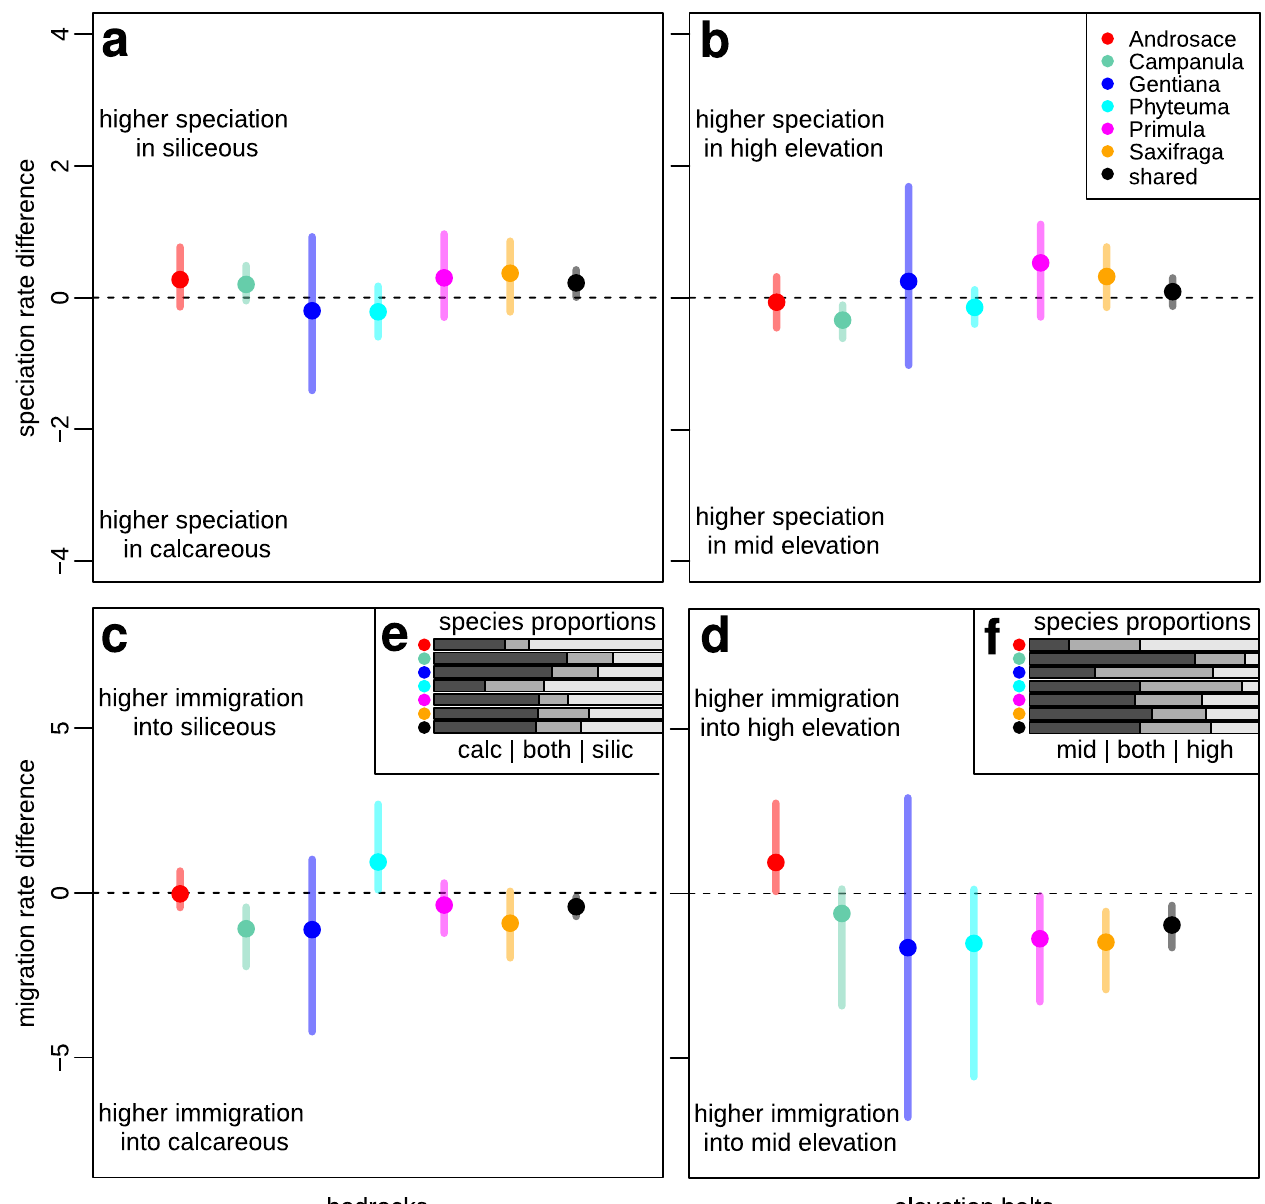
Fig. 3 Evolutionary assembly across bedrocks and elevational belts based on ClaSSE models. a , c The differences between siliceous and calcareous habitats in constant-state speciation and migration rates, respectively. b , d The differences between high and mid-elevation habitats in constant-state speciation and migration rates, respectively. The dots represent mean parameter estimates and the bars indicate 95% credibility intervals, based on 5000 MCMC samples from the ClaSSE model posterior. Black dots and bars represent the shared parameter estimates from the multi-clade model, where each of the 6 phylogenies is regarded as an independent realization of the same diversi fi cation process. e The proportions of species inhabiting siliceous, calcareous or both types of habitats (light, dark and middle gray, respectively), and f the proportion of species inhabiting high elevation, mid-elevation or both types of habitats (light, dark and middle gray, respectively). Source data are provided as a Source Data fi